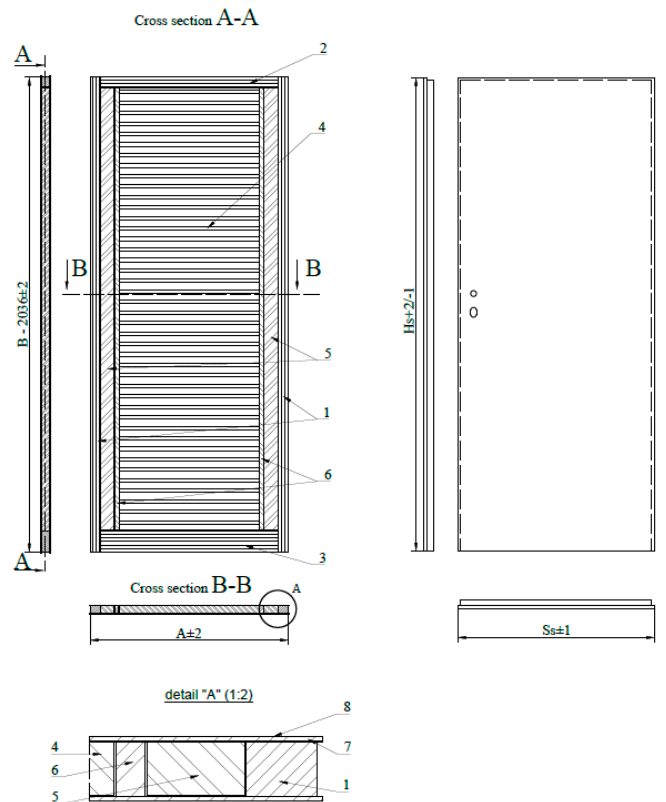
Figure 4. Door construction 2.